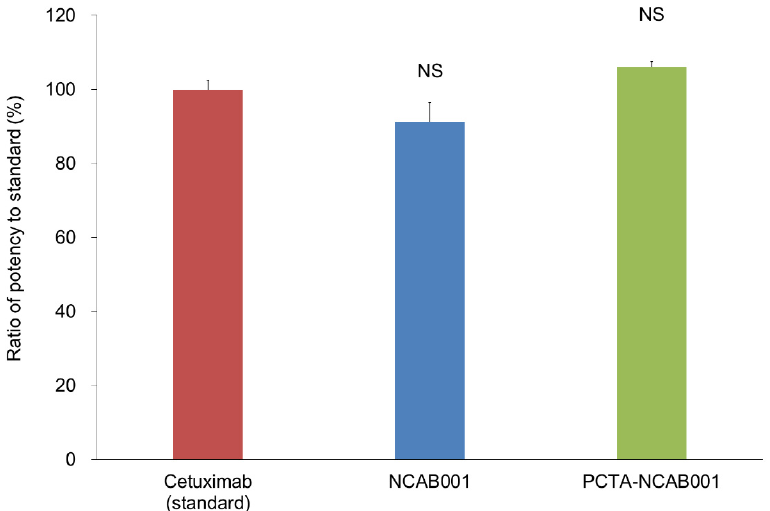
Figure 2. The relative binding potency of NCAB001 and PCTA-NCAB001 against recombinant human EGFR was determined by the enzyme-linked immunosorbent assay (ELISA). Cetuximab was used as the reference standard. NS = not significant vs. standard.